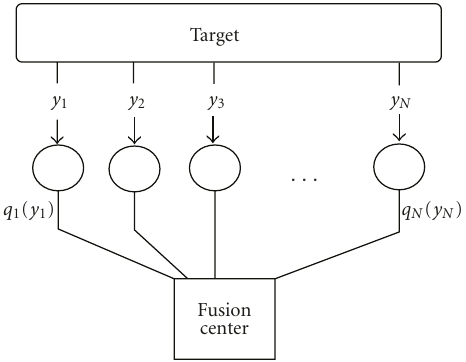
Figure 1: Decentralized detection system with fusion